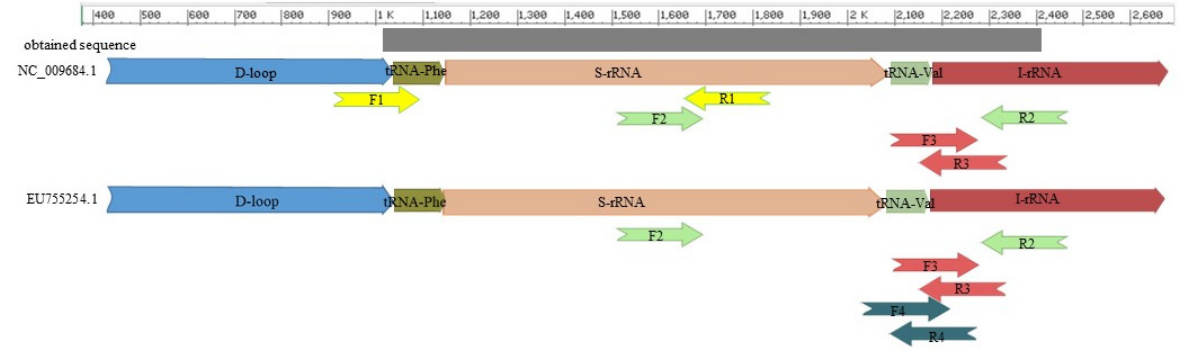
Figure 1. The place of the primers annealing to the mitochondrial genome of ducks and the sequences obtained.